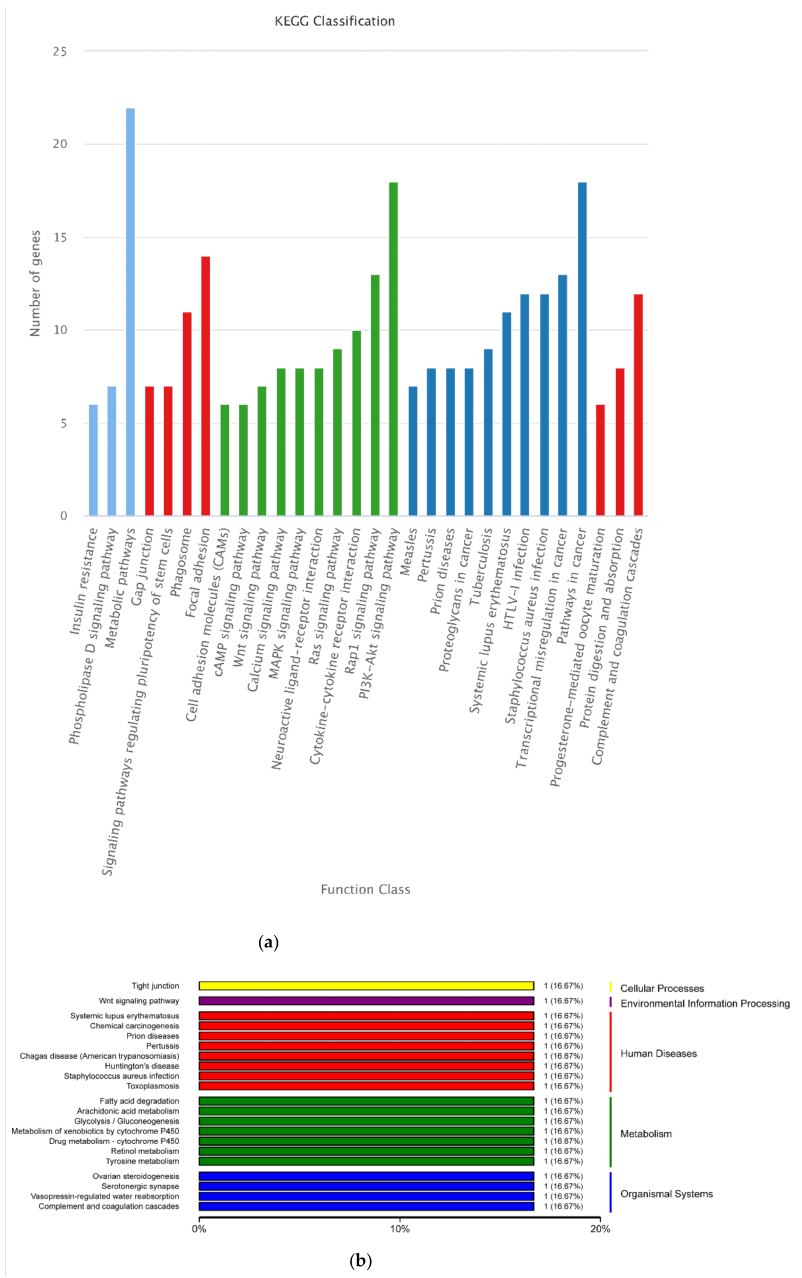
Figure 12. KEGG classification of the 488 DEGs and 16 DEPs. ( a ) KEGG classifica-tion of the 488 DEGs. “Metabolic pathways,” “PI3K-Akt signaling pathway,” and “Pathways in cancer” classi- fied the most DEGs. ( b ) KEGG classification of 16 DEPs. Only one DEP annotated to each pathway. Table 3. Integrative analysis of transcriptome and